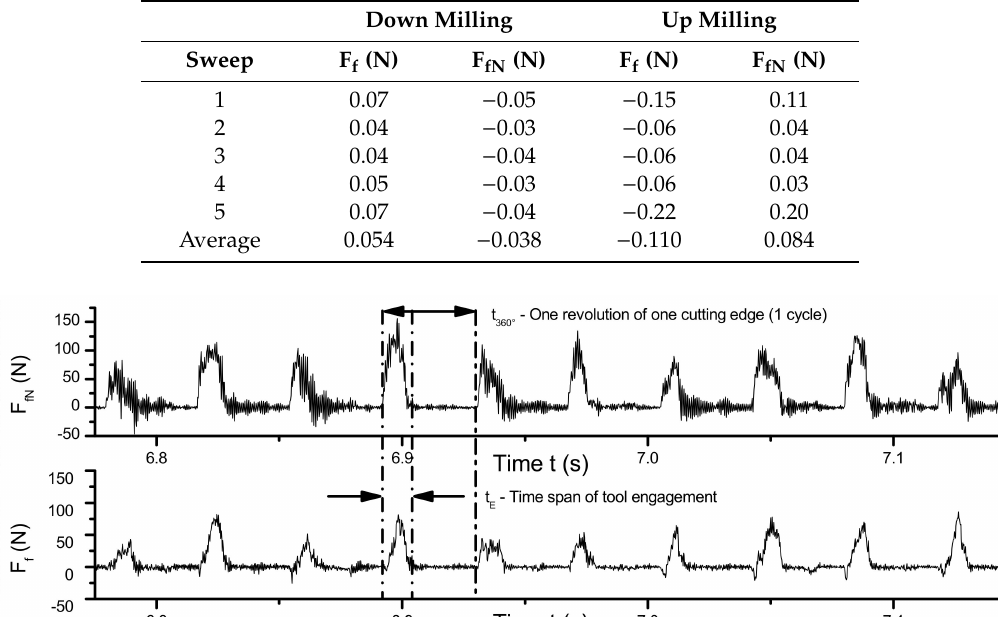
Table 7. Average reaction forces for the peripheral milling (Model A, v c = 100 m / min, f z = 0.05 mm).